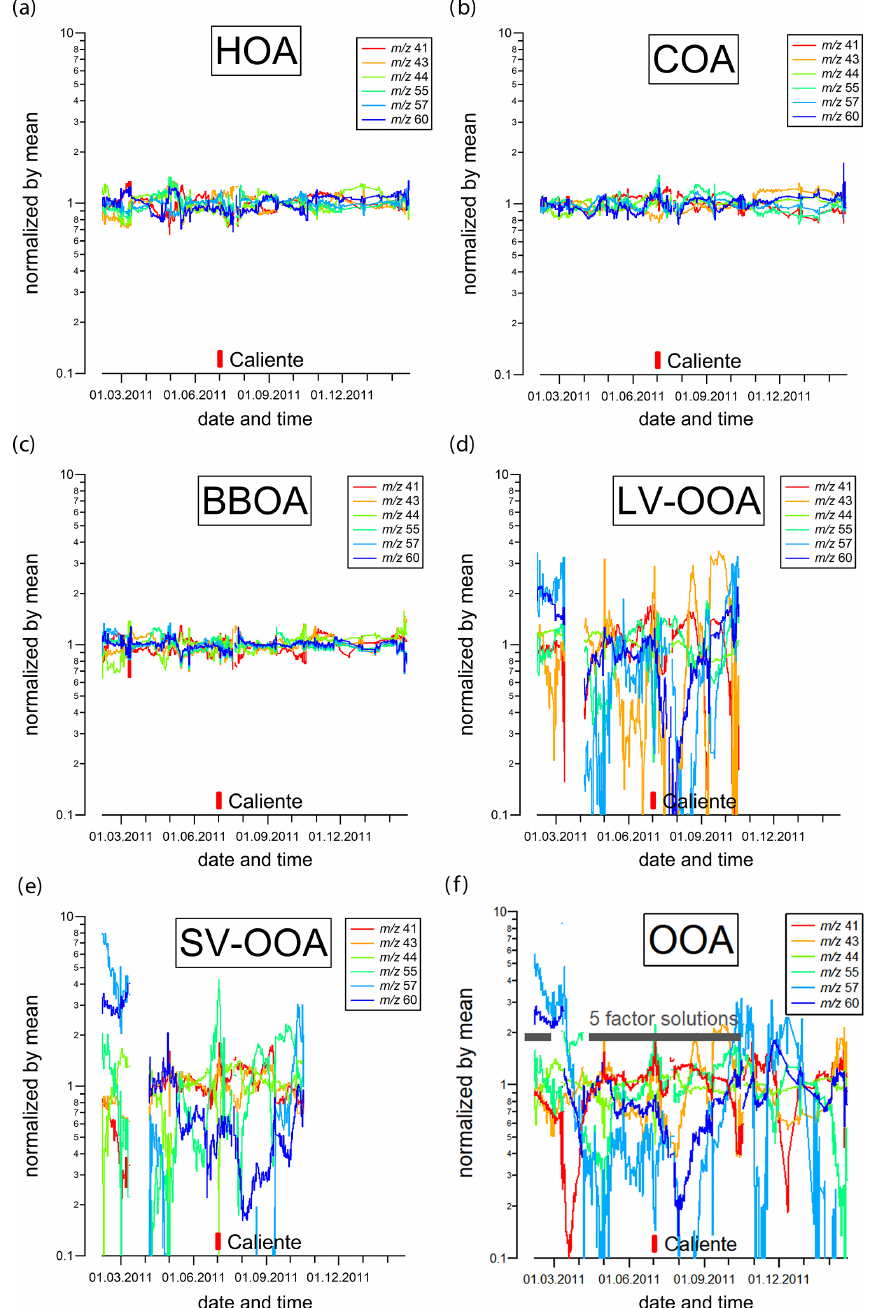
Figure 6. Daily averaged fractions of important AMS/ACSM m/z tracers. Each variable is normalized by its mean to better stress its temporal